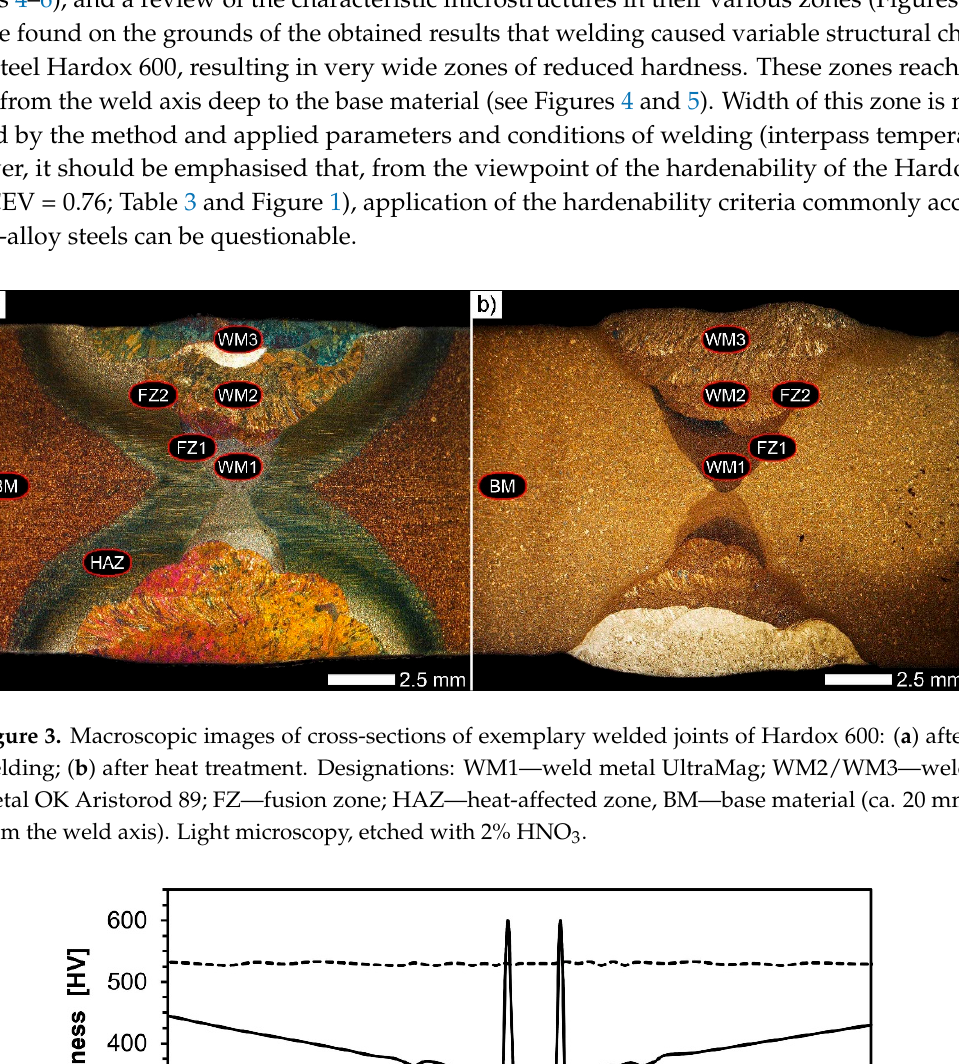
Figure 5. Hardness distribution in the welded joint of Hardox 600 along line 2 shown in Figure 2b: AW—after welding; HT—heat-treated.